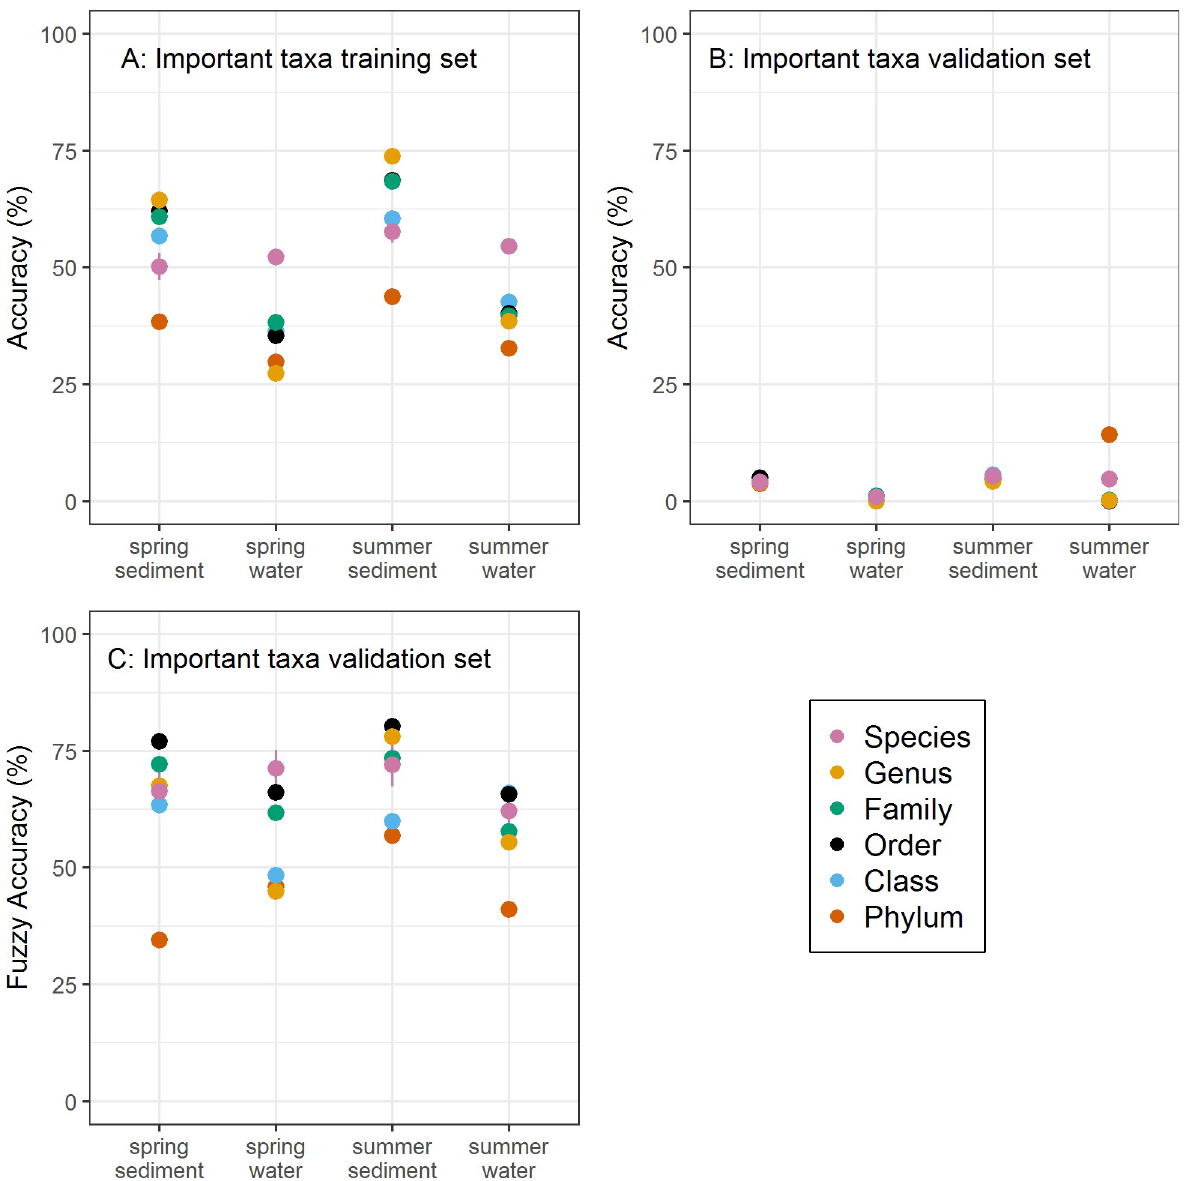
Fig 3. Stream assessment classification accuracy with a subset of important taxa. Model classification accuracy of sites into 8 possible BIBI categories based on models using only those taxa loading heavily (0.03 or greater) in the DAPC analysis. Accuracies are shown for the training dataset (A), validation dataset (B), and the fuzzy classification accuracy for the validation dataset (C) across the differing levels of taxonomic resolution, sampling season (spring, summer), and sampling substrate (water, stream sediment). Points represent the mean accuracy of 1,000 model runs resampling 80% of the dataset to form the training dataset and the remaining 20% comprising the validation dataset.